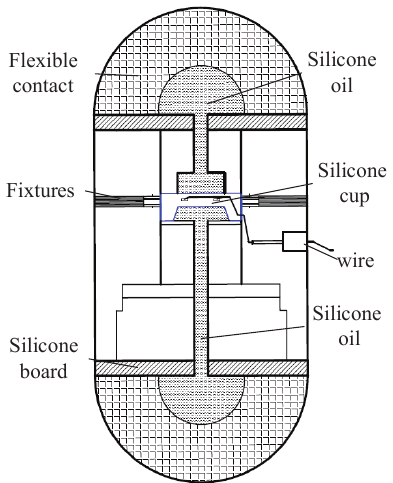
Figure 3. The structure diagram of capsule